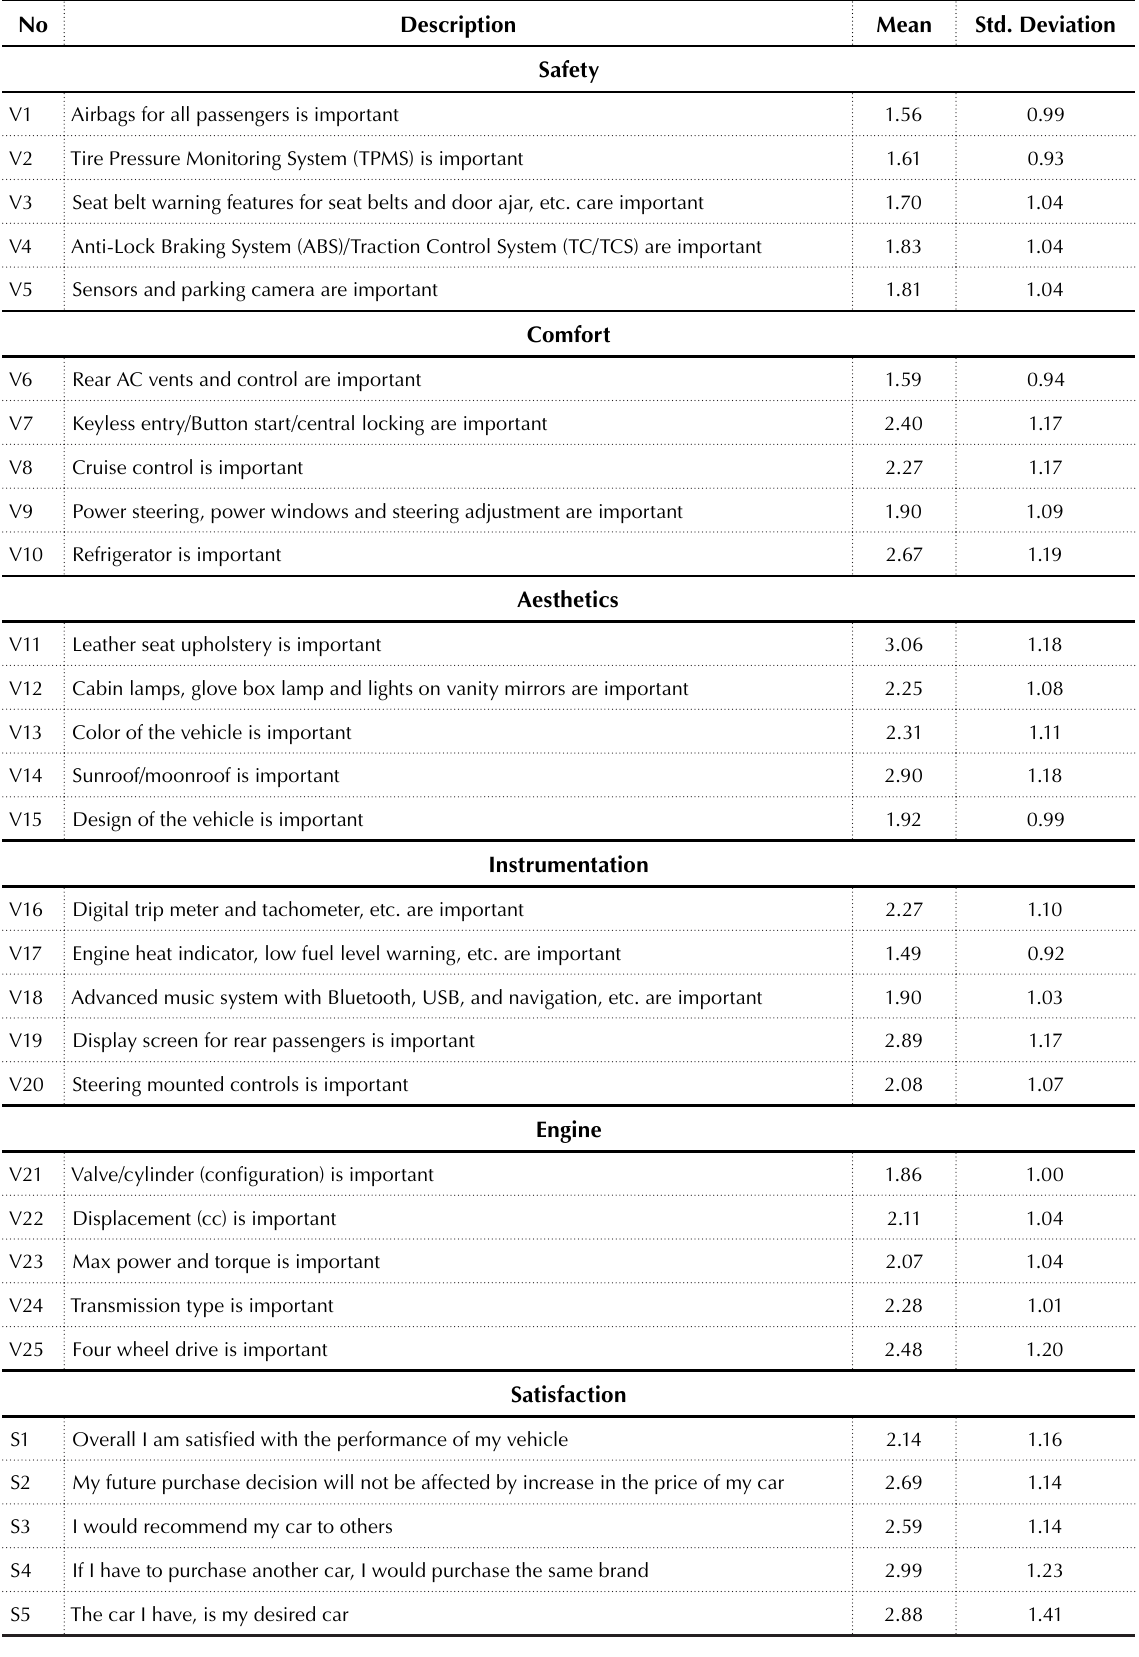
Table 2. Descriptive statistics of the